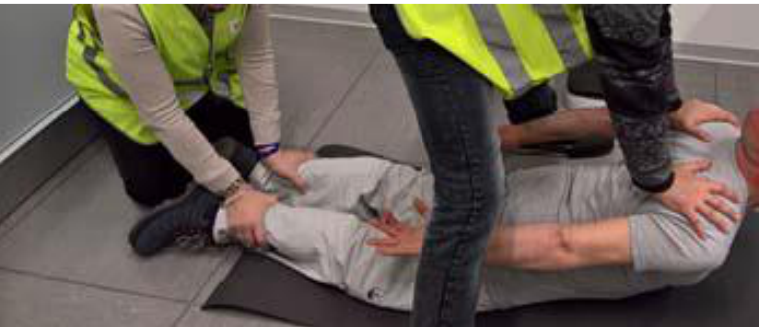
Figure 4. Isometric contraction test (maximum voluntary contraction) for the Erector Spinal muscles. The figure shows the prone position of the worker who performed a back extension involving